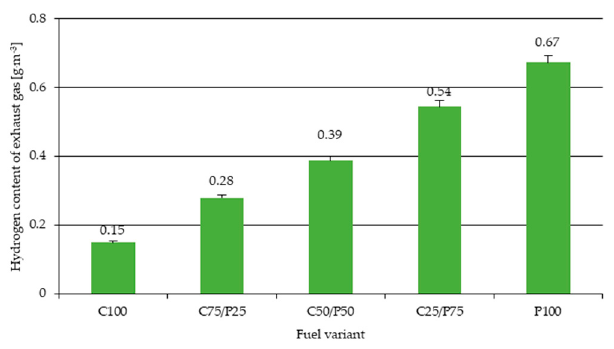
Figure 11. Dependence of the excess air coefficient on fuel variant.